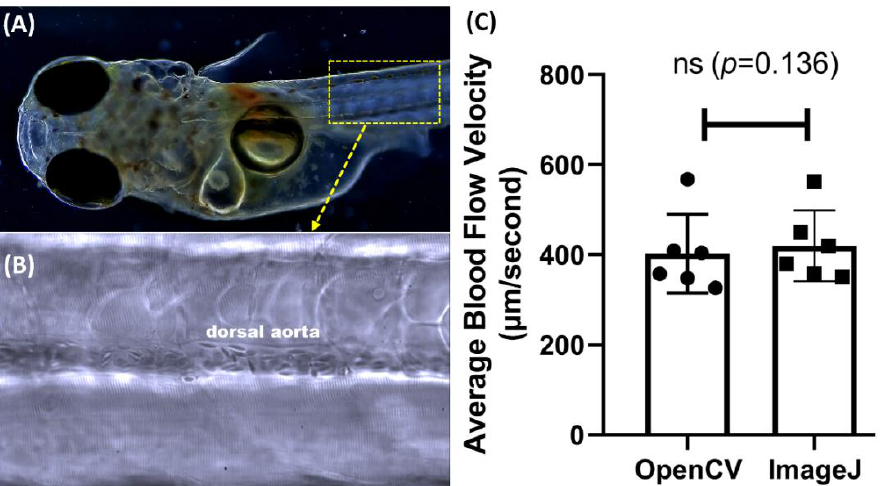
Figure A2. Comparison of medaka blood flow velocity calculations using ImageJ and OpenCV methods. ( A ) The selected ROI area in the dorsal aorta was used for blood flow analysis in medaka larvae. ( B ) High magnification of ROI area focused on the dorsal aorta. ( C ) Side-by-side comparison of the average blood flow velocity done by ImageJ or OpenCV methods. The data were shown as mean with standard deviation, and a significant difference was calculated using paired t -test. (ns = no significance, n = 6). (circle dots show the data analyzed by OpenCV, while square dots show the data analyzed by ImageJ).